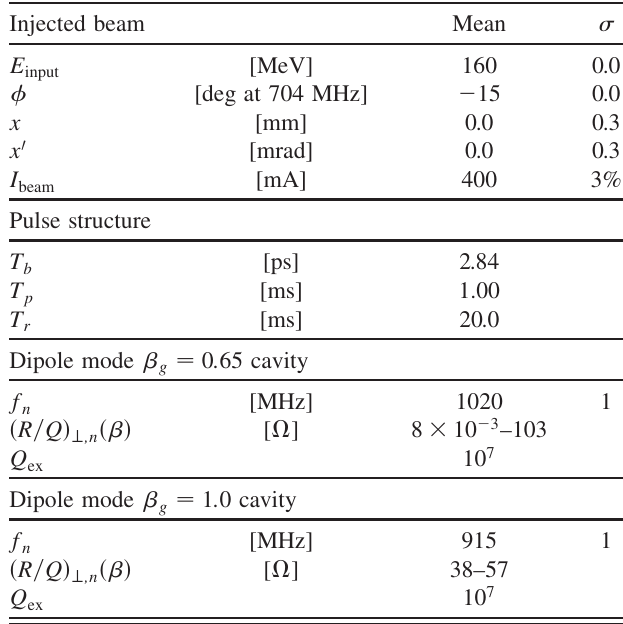
TABLE IX. Default settings used in all transversal beam dy- namics simulations.